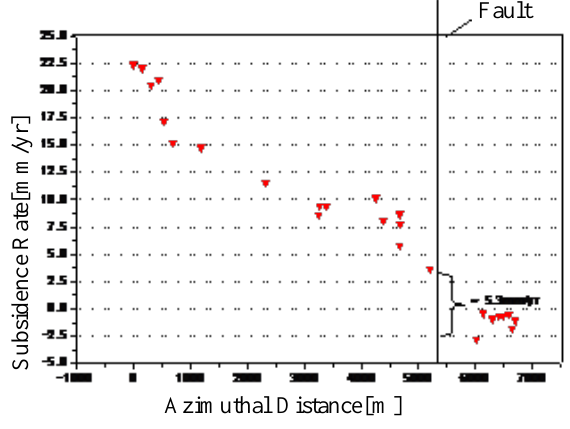
Figure 6: Annual Subsidence Rate on the Two Sides of the